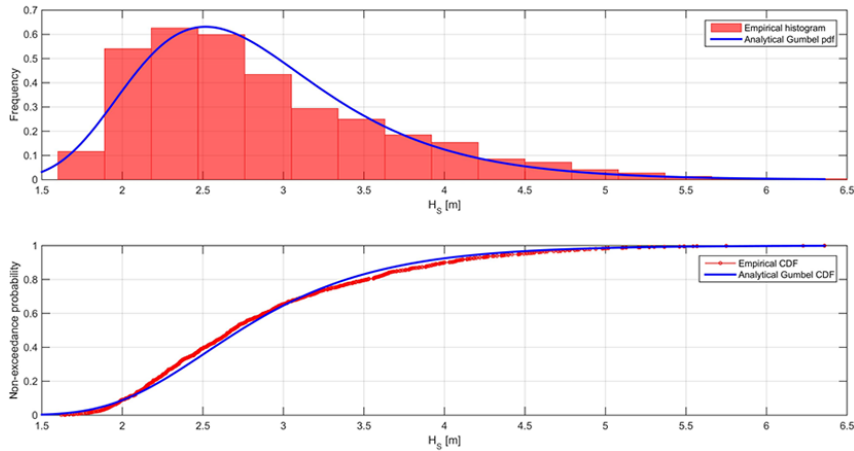
Figure 3. Interpretation of the wave data at the study area: (a) empirical and analytical PDF and (b) empirical and analytical CDF for the identified peak values.